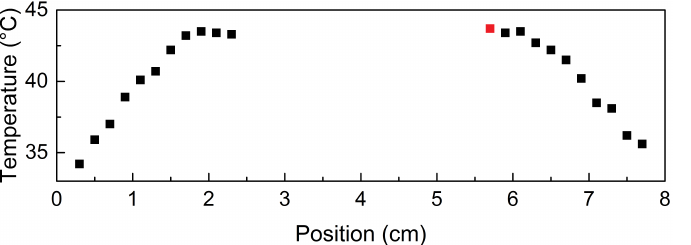
Figure 10. Exemplary temperature profile along the center axis of the gas cell. The absolute positions 0 and 8 cm correspond to the inner faces of the two gas cell sapphire windows. The Pt100 sensor position, which has been used for the reference temperature measurement in Figure 9, is highlighted with a red